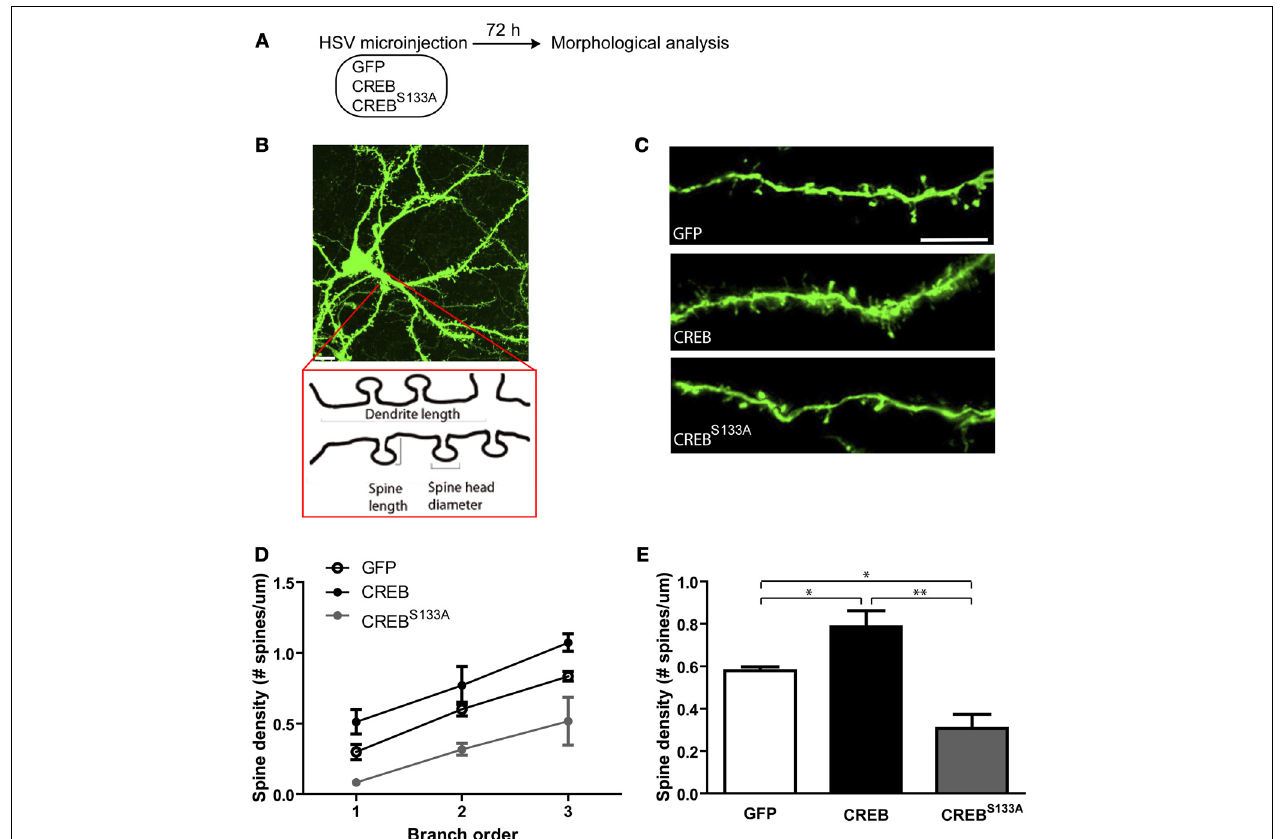
FIGURE 2 | CREB modulates dendritic spine density in LA neurons. (A) Experimental design. The morphology of infected LA neurons was analyzed 72h after mice were microinjected with GFP, CREB or, CREB S133A vectors (at the same time-point as training occurred in Figure 1 ). Mice remained in the homecage after microinjection and were not fear conditioned. (B) Schematic representation of a dendritic segment showing the parameters analyzed (dendrite length, spine length, spine